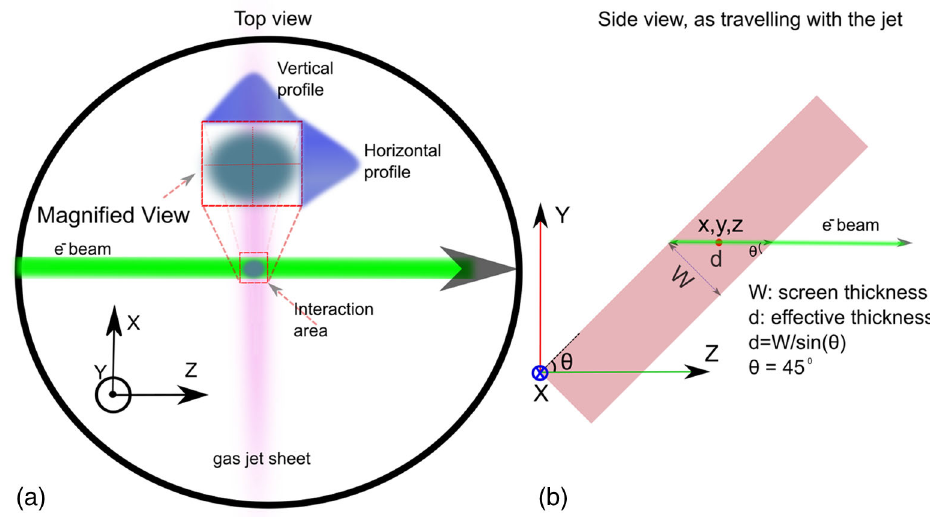
FIG. 6. (a) Schematic of the particle beam-gas jet interaction viewed from above. Gas jet sheet shown in purple, electron beam in green. (b) Side view and gas screen